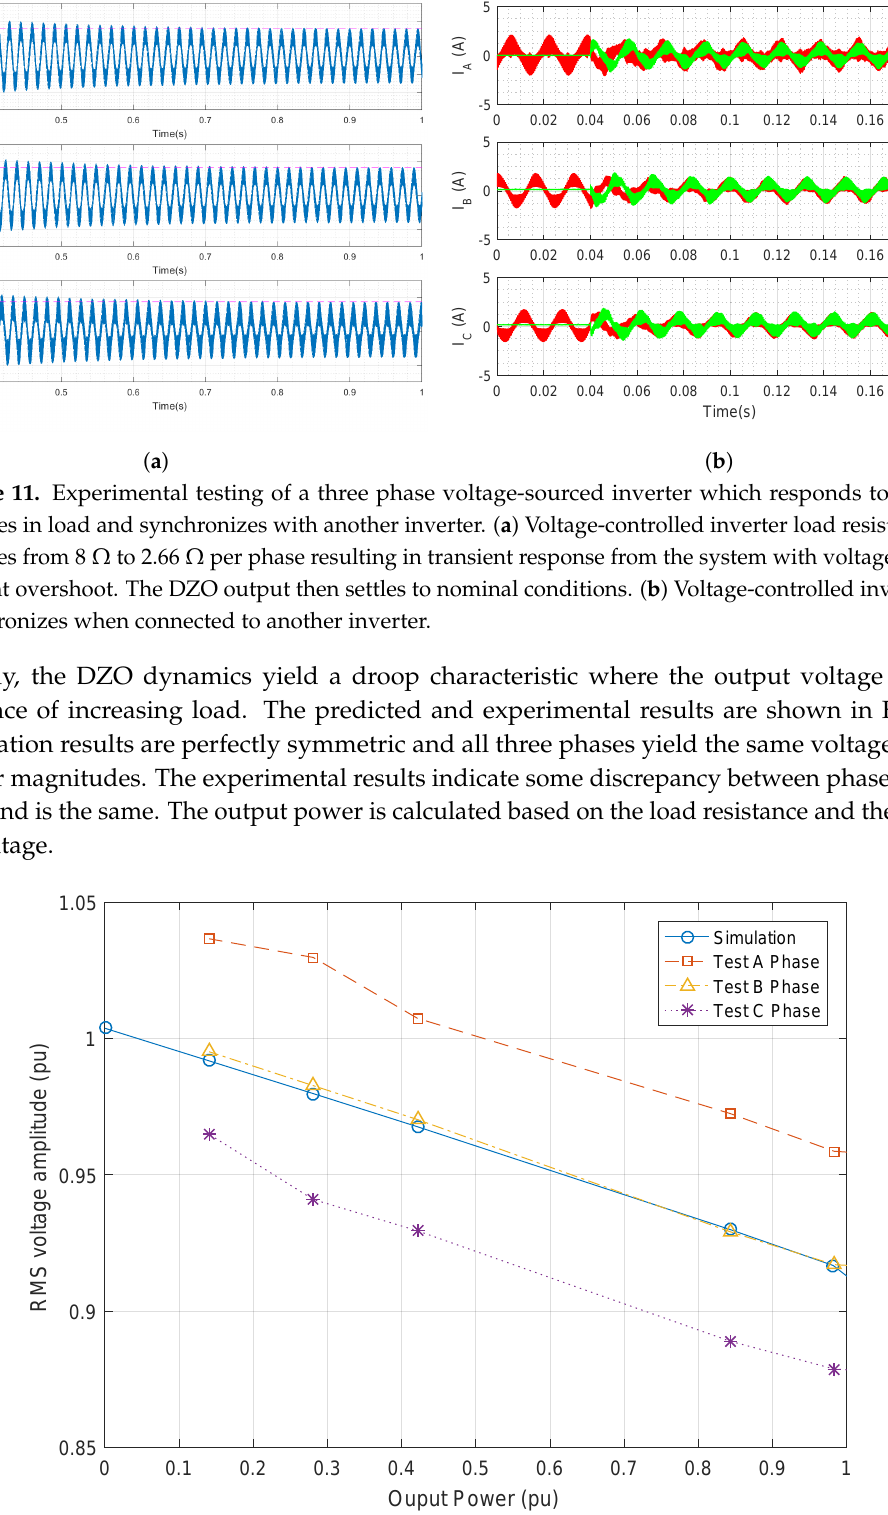
Figure 12. Three-phase voltage-controlled inverter droop characteristic demonstrated in